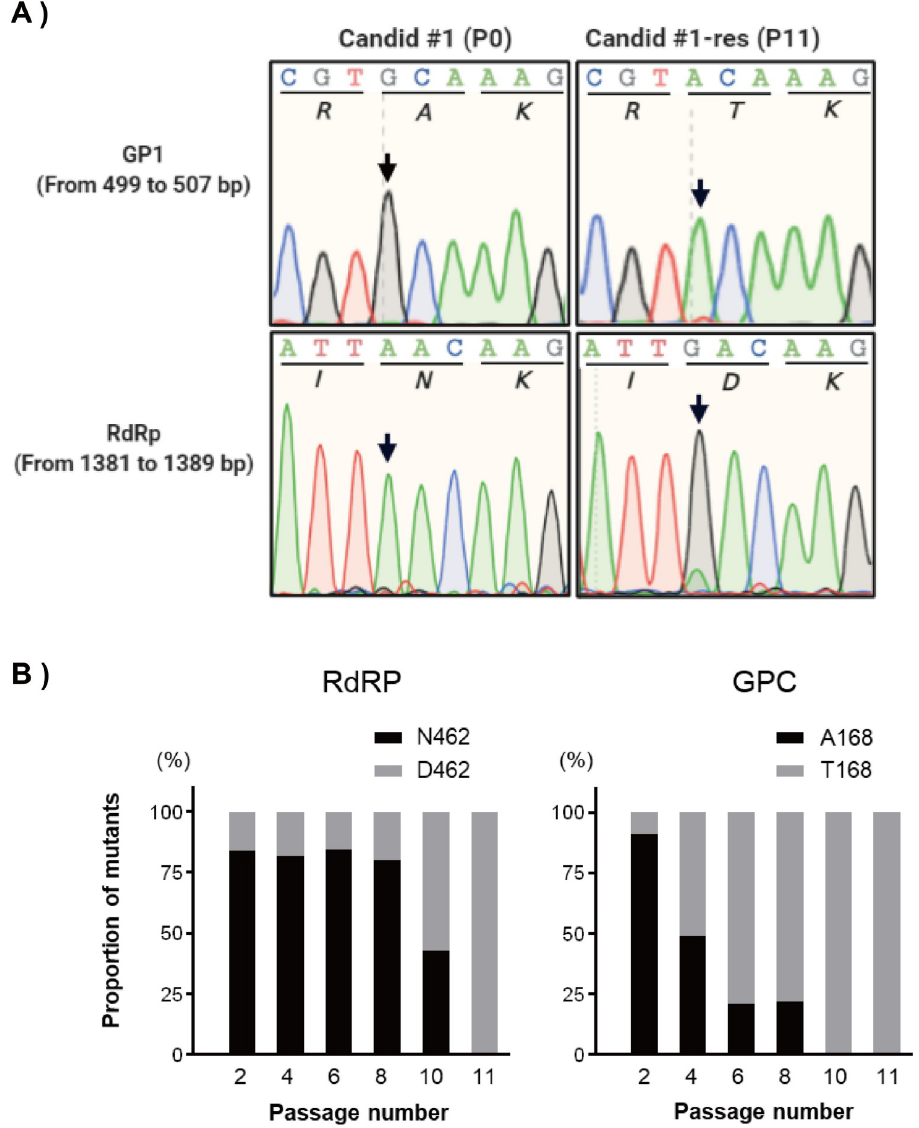
Fig 2. Nucleic acid substitutions in RdRp and GPC open reading frames. (A) Representative chromatograms of mutations of favipiravir resistant JUNV Candid #1, passage 11 (P11) are shown in comparison to the parental virus population (P0). Amino acid residues are shown below each codon. Arrows indicate mutation locations. (B) The proportions of RdRp-N462D (left panel) and GPC-A168T (right panel) mutations in every other